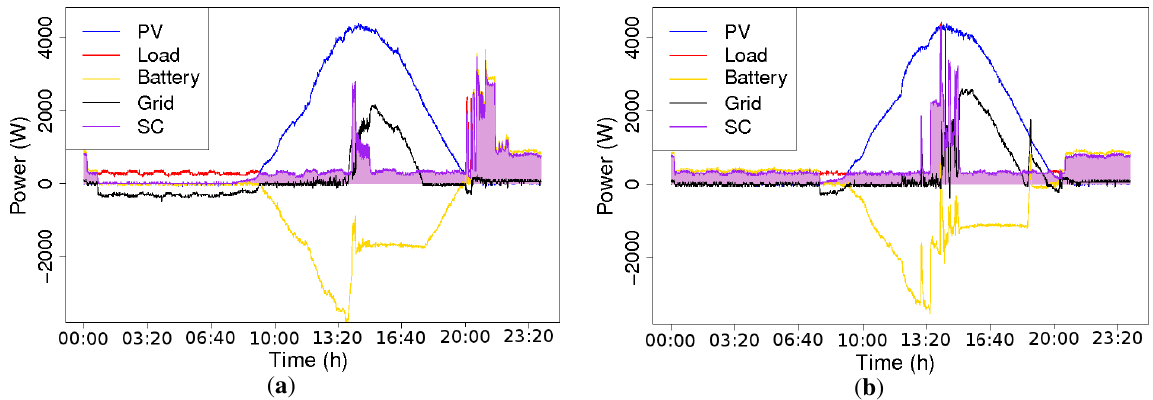
Figure 6. Complete operation example: ( a ) ES1 and ( b )